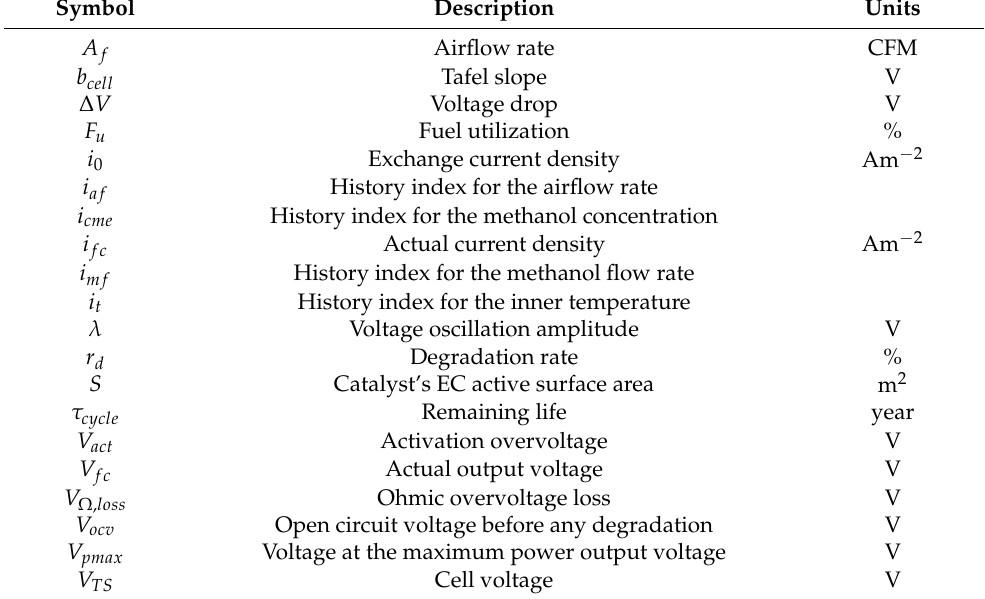
Table 5. Nomenclature for fuel